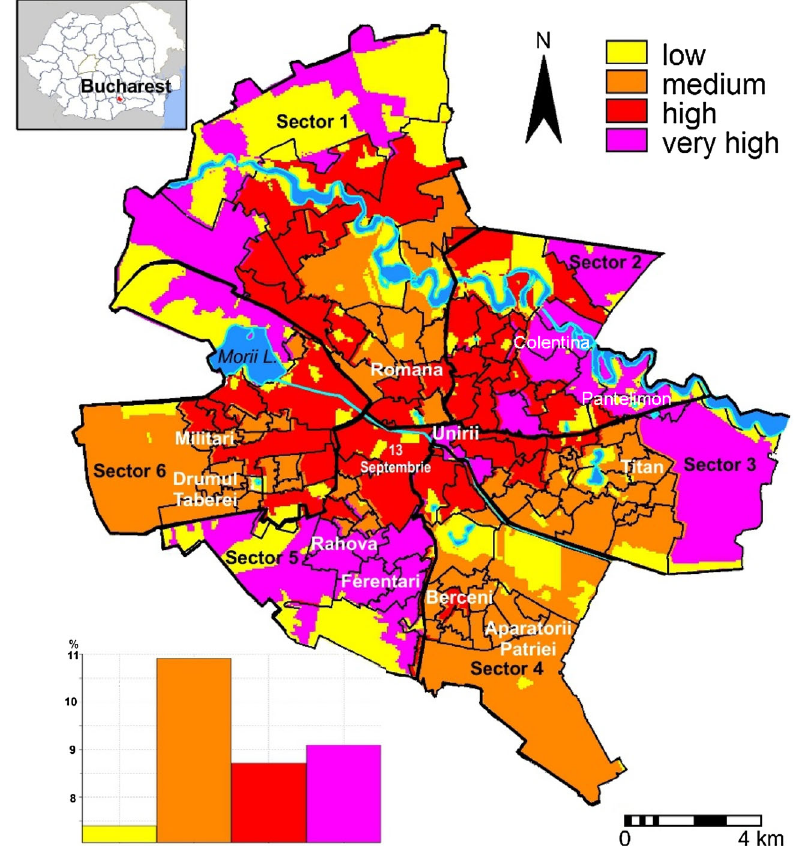
Fig. 6 Overall vulnerability map of Bucharest. The analysis was performed at census tract level. The graph shows the percentage of census tracts in each